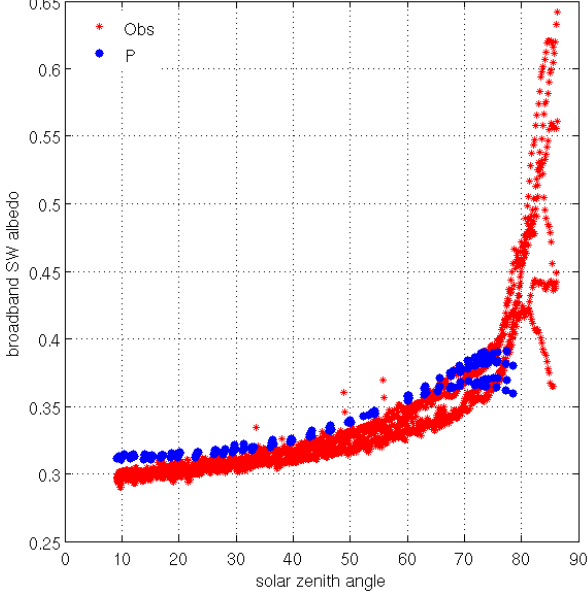
Figure 2. Surface downwelling fluxes at Solar Village. The top panel presents SW surface downwelling perturbed experiment di- rect (P dir, black stars) and diffuse (P dif, purple stars), in situ mea- sured direct (Obs dir, red circles) and diffuse (Obs dif, blue circles) fluxes and Aeronet SDA column AOD at 500nm (green, right verti- cal axis). The bottom panel presents LW surface downwelling per- turbed experiment (P, black stars) and in situ measured (Obs, red circles) fluxes.